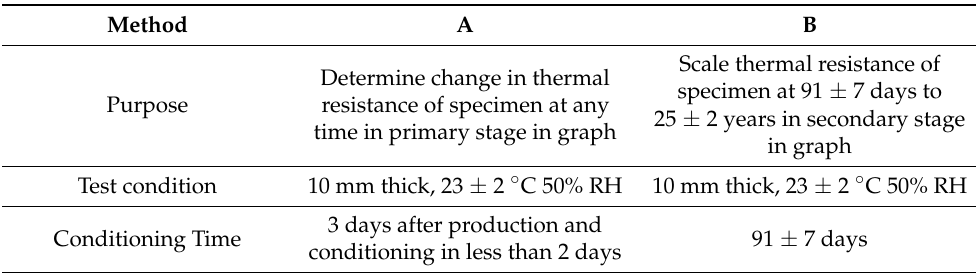
Table 2. Details of methods A and B in ISO 11561.